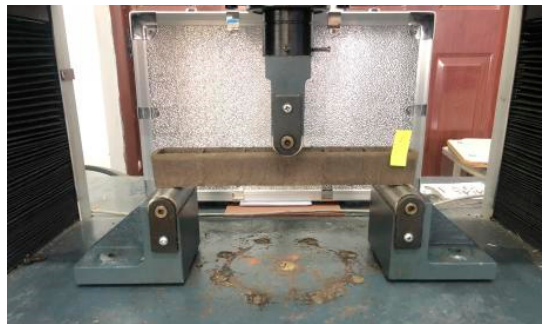
Figure 4. Failure analysis of three-point bending of a seedling tray.